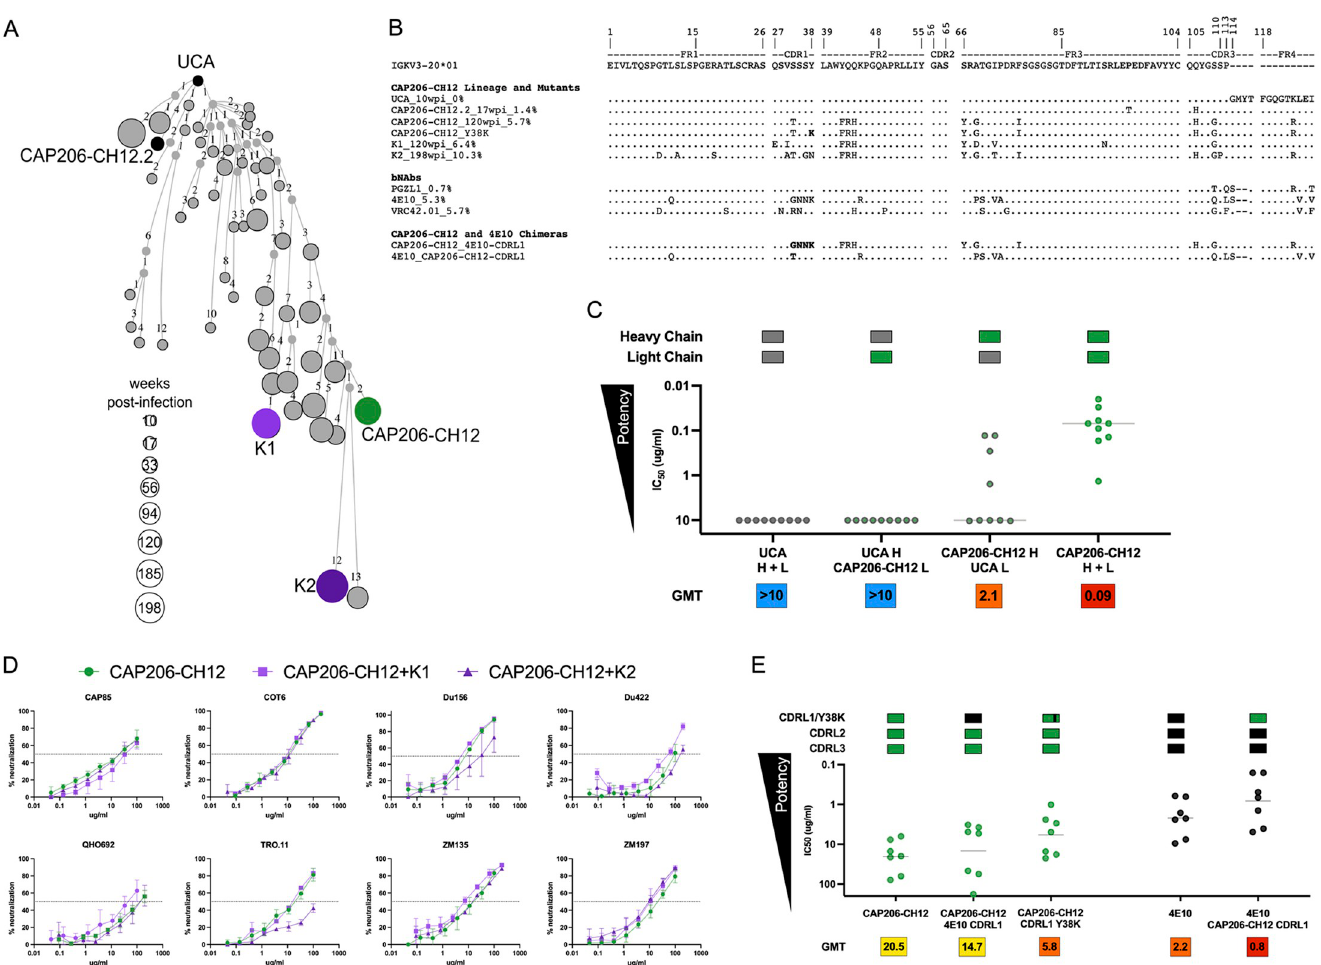
Fig 2. CAP206-CH12 lineage light chain plays a minor role in neutralization. (A ) CAP206-CH12 lineage reconstruction tree of light chain clonally related sequences. Small nodes present intermediate sequences inferred by Change-O, part of the immcantation portal, while larger circles represent clonally related sequences observed in the NGS data, sized according to weeks post-infection. The UCA, CAP206-CH12.2, CAP206-CH12 as well as two additional light chains (K1 and K2), used for further analysis, are labeled, and shown as black or coloured circles on the tree. (B) Alignment of light chains of the UCA, CAP206-CH12.2, CAP206-CH12, K1, K2, PGZL1, 4E10 and VRC42.01 and 4E10/CAP206-CH12 chimeras against their shared IGKV3-20 germline gene. Sequences are numbered according to the IMGT numbering system (www.imgt.org). ( C) Neutralization of autologous viruses from the first year of infection by the UCA, CAP206-CH12, and UCA/CAP206-CH12 heavy and light chain chimeras. Shown are the IC 50 titres, with the line representing the geometric mean titre of all viruses which is also given under the graph for each mAb. Coloured blocks above each mAb are schematics representing the heavy and light chain usage coloured by mAb, with CAP206-CH12 in green and the UCA of the lineage in grey. (D) Neutralization curves of CAP206-CH12 with its natively paired heavy and light chains (green) in comparison to CAP206-CH12 heavy chain paired with either K1 (light purple) or K2 (dark purple) against eight heterologous viruses. Shown are the average neutralization titres (IC 50 in μ g/mL) with the error bars representing standard deviations. ( E ) Neutralization of heterologous viruses by CAP206-CH12, 4E10 and CDRL1 chimeric antibodies, as well as CAP206-CH12 with the K 38 mutation. Shown are the IC 50 titres with the lines representing geometric mean, which is also given beneath each mAb. Coloured blocks above each mAb are schematics representing the CDRL regions coloured by mAb, with CAP206-CH12 in green and 4E10 in